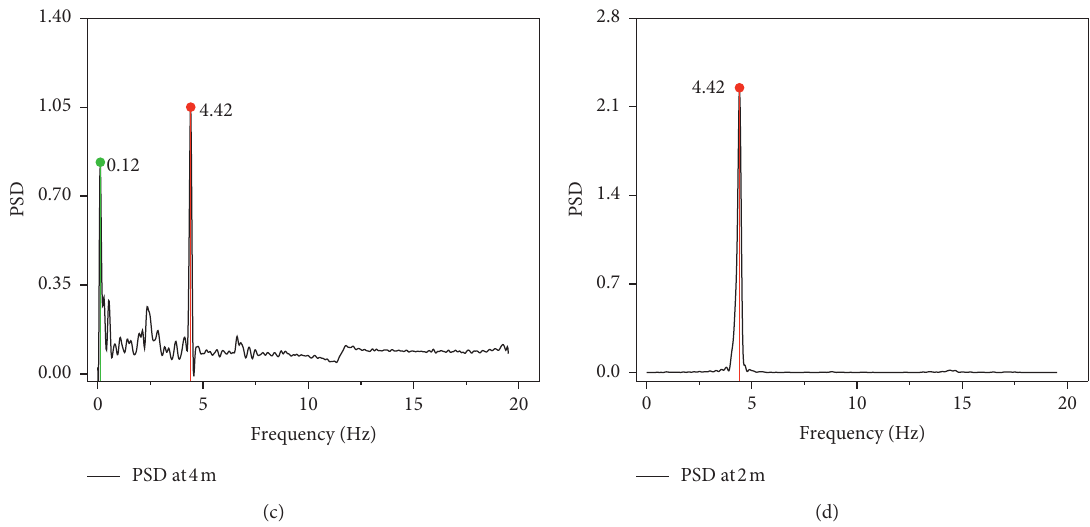
Figure 6: DIC measurements of node 15 obtained from 2m and 4 m away. (a) Time history at 4 m. (b) Time history at 2m. (c) PSD at 4m. (d) PSD at